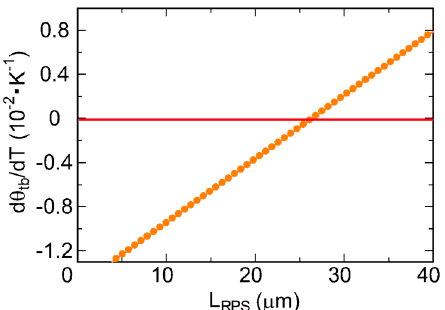
Figure 6. Calculated temperature dependence of the total phase difference on the length of reciprocal phase shift L RPS . Red line indicates the point to be zero.